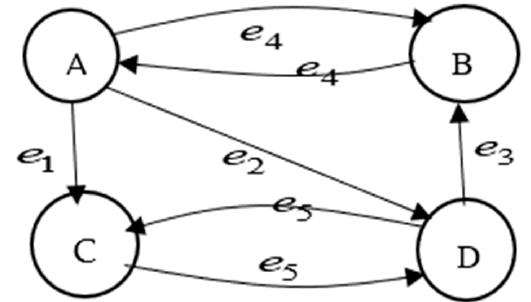
Figure 2. Semidirect graph (bidirectional edges).